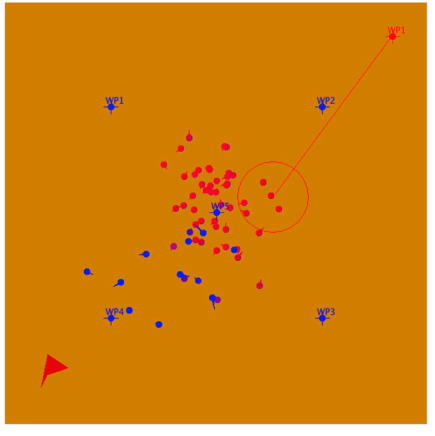
Figure 4. Pythagoras “Peace” Scenario spatial view. Blue represents Marines, red the Instigator, and shades in between are